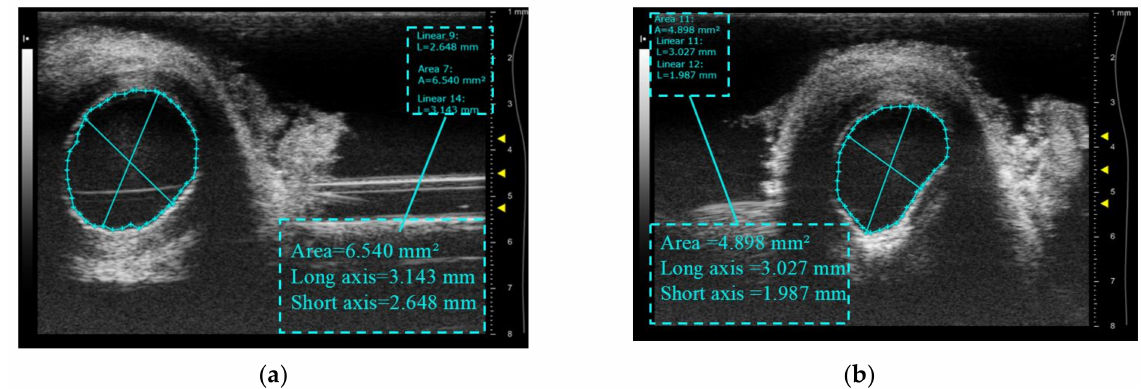
Figure 15. Cross-sectional ultrasound comparison images of blood vessels before and after treatment: ( a ) before treatment; ( b ) after